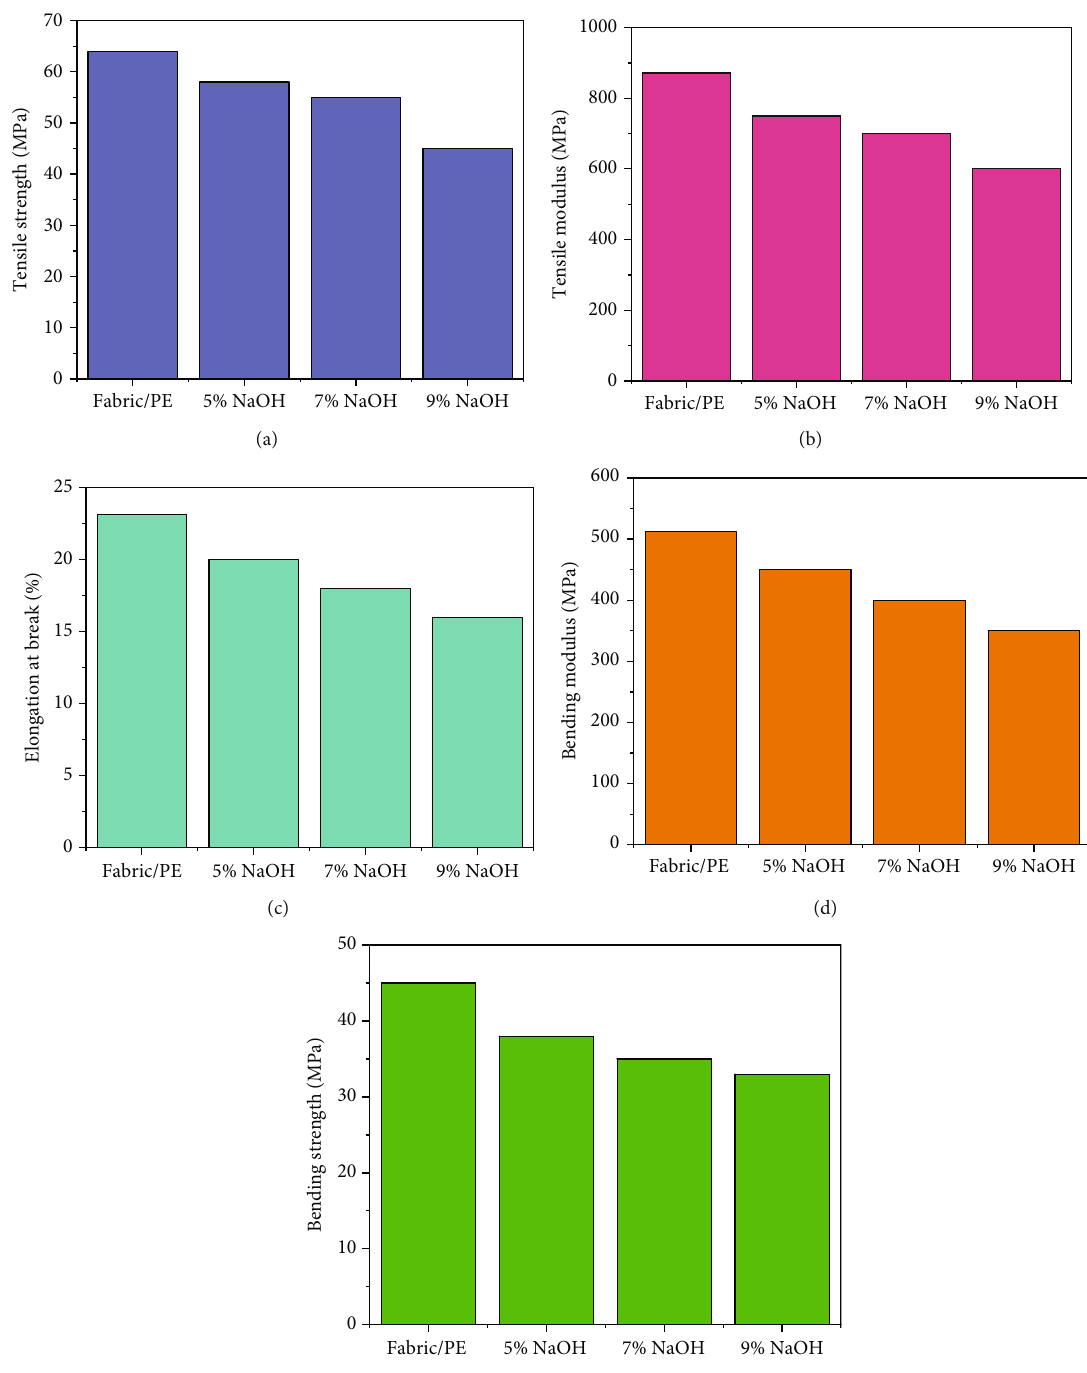
Figure 4: Alkali ’ s e ff ect on the composites ’ mechanical characteristics: (a) tensile strength, (b) tensile modulus, (c) elongation, (d) bending modulus, and (e) bending